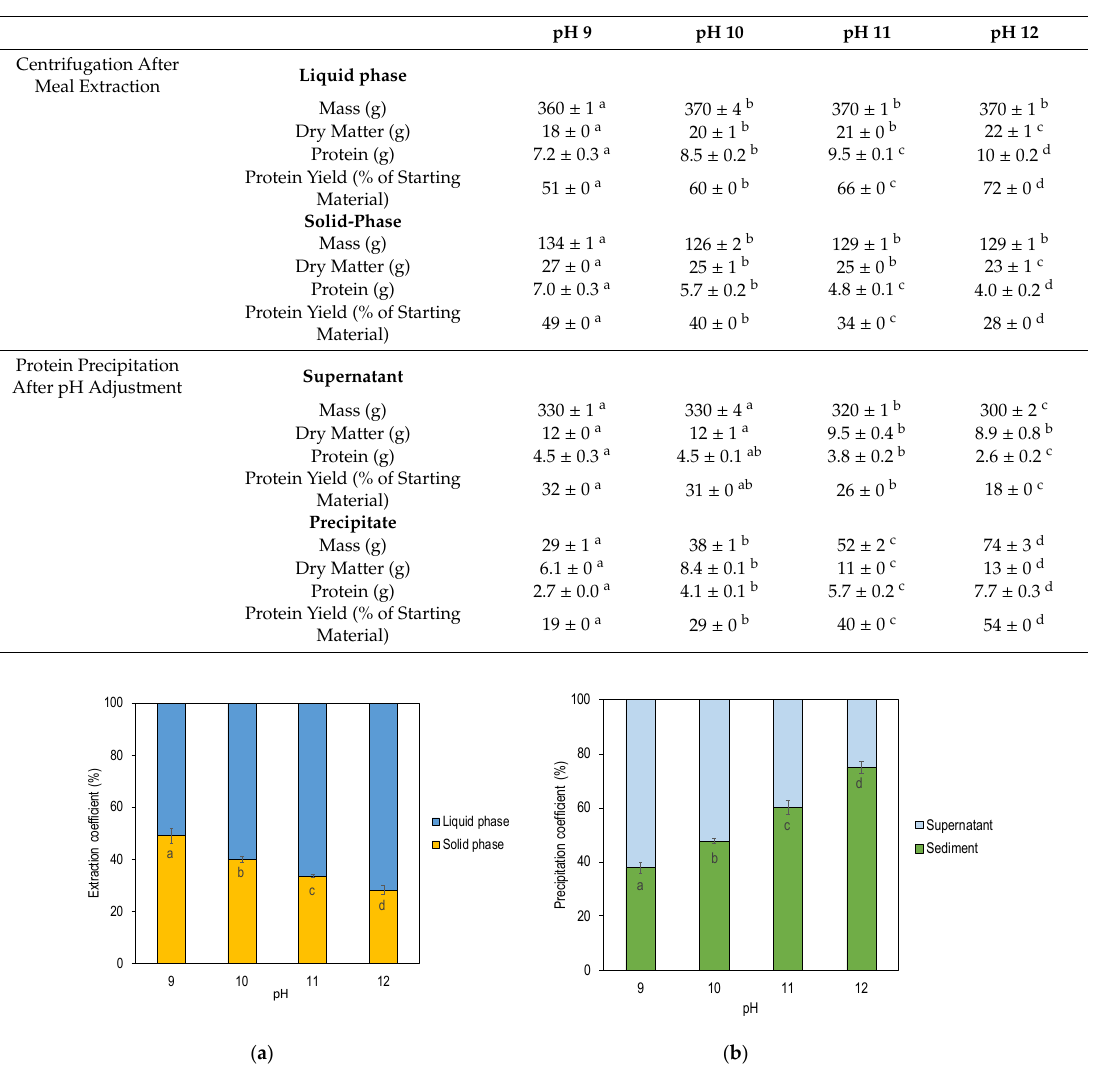
Table 1. Mass balance over the protein recovery process with di ff erent alkali pH in the extraction phase. The starting material had a mass of 50 ± 0 g for each batch, the dry matter was 46 ± 0 g and protein content was 14 ± 0 g. Data are expressed as mean ± standard deviation. Di ff erent letters in each row indicate significant di ff erences, p < 0.05.